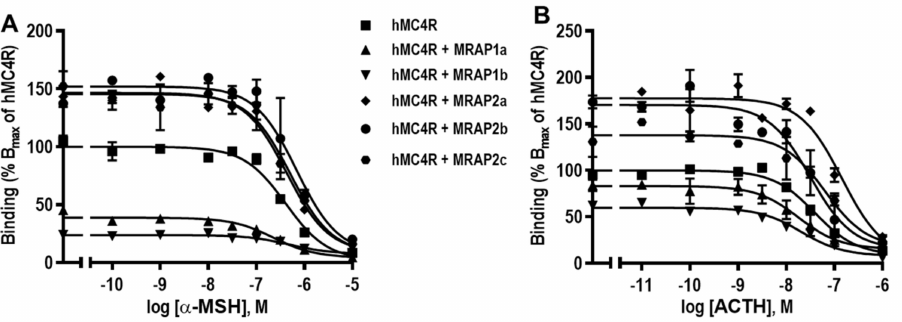
Figure 6. The ligand-binding properties of hMC4R regulated by hMRAP1s or hMRAP2s to α - MSH ( A ) and ACTH ( B ). HEK293T cells were transiently transfected with hMC4R with or without MRAP1a, MRAP1b, MRAP2a, MRAP2b or MRAP2c plasmids (1:5), and the binding properties were measured 48 h later by displacing the binding of 125 I-NDP-MSH using different concentrations of unlabeled α -MSH and ACTH(1–24). Data are expressed as % of hMC4R binding ± range from duplicate measurements within one experiment. All experiments were performed at least three times